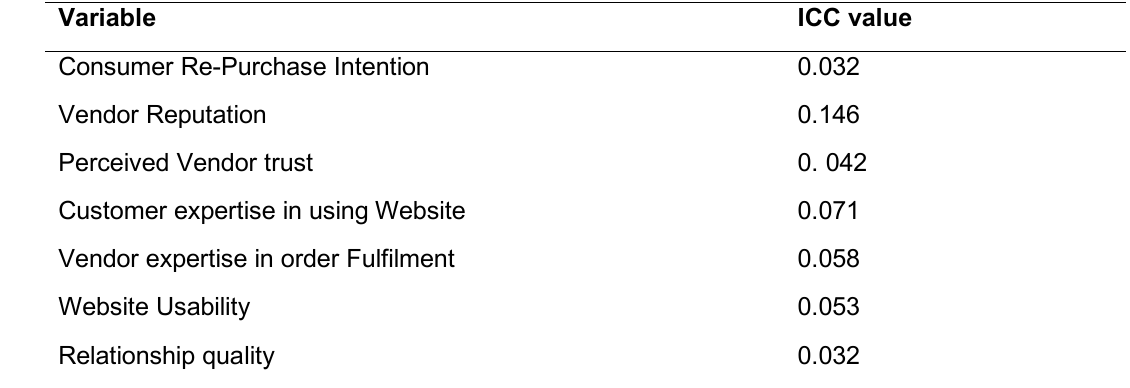
Table 3: Intra-class Correlation Coefficients of the